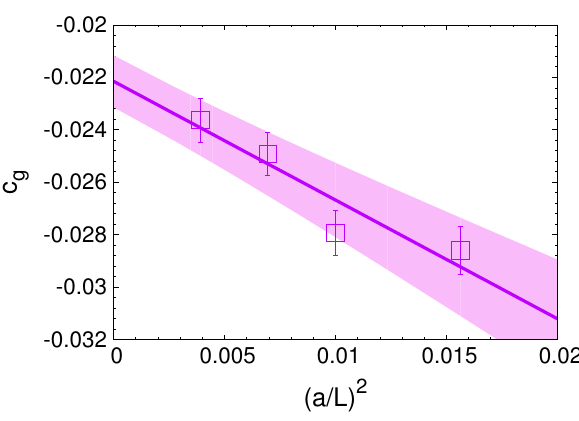
Figure 8 . The coe(cid:14)cient c g ( a=L ) vs ( a=L ) 2